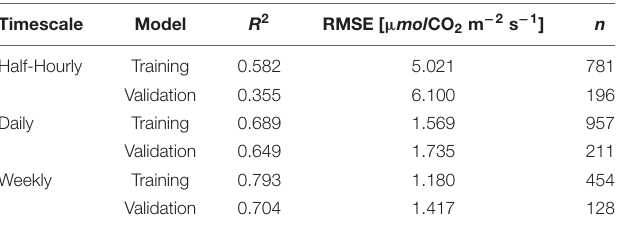
TABLE 5 | Decision tree model